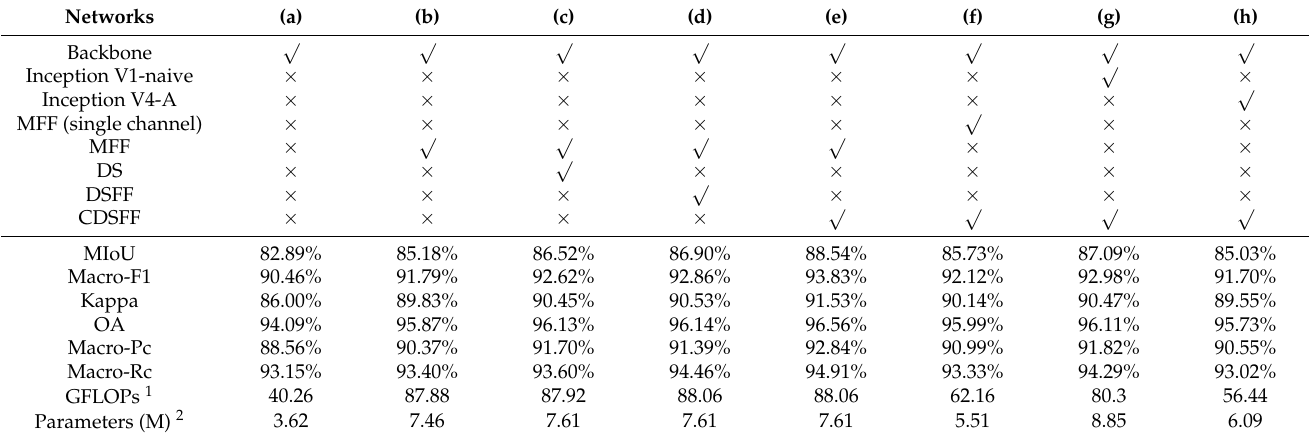
Table 3. The detection accuracy, time complexity, and spatial complexity of various ablation networks on the CSWV_S6.